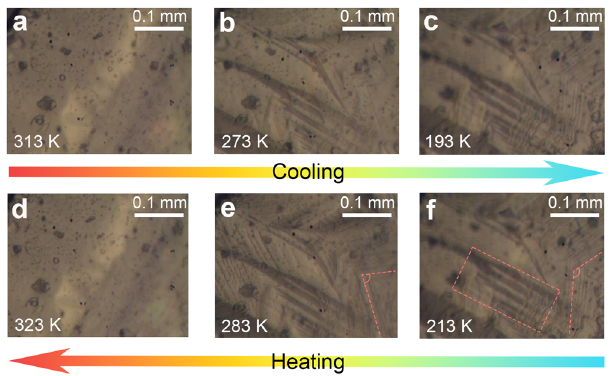
Fig. 4 | Temperature-dependent evolution of the ferroelastic domain struc- tures of 1. a – c Emergence and evolution of ferroelatic domains during cooling. d – f Evolution and disappearance of ferroelastic domains during